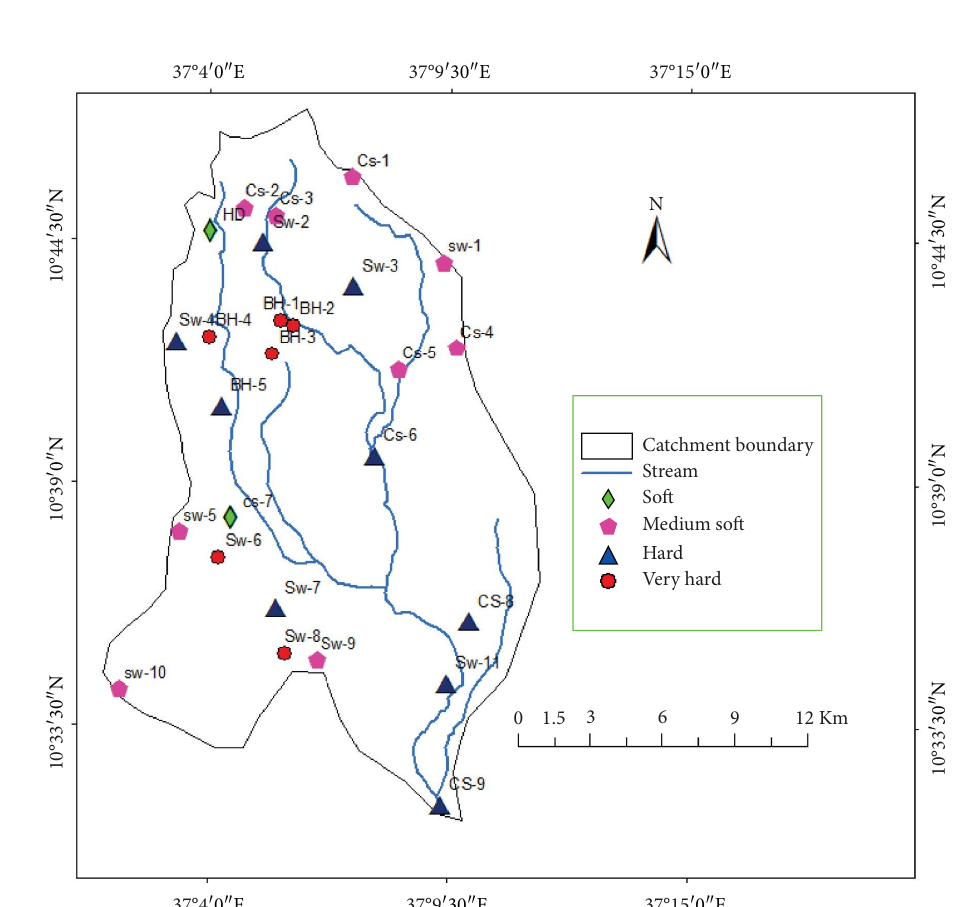
Figure 8: Spatial variability map of